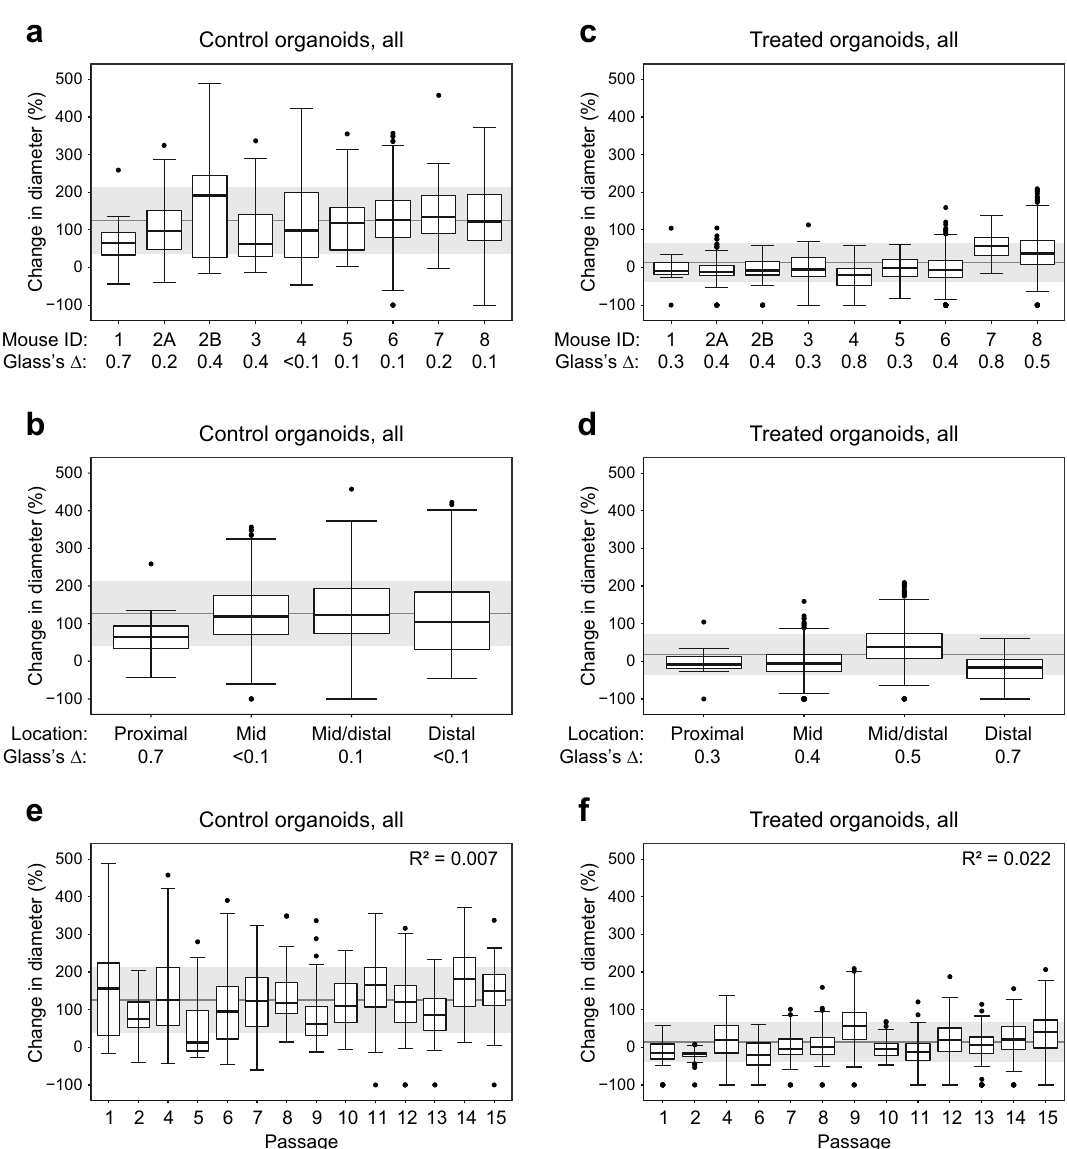
Figure 3. MDCOs derived from different mice of the same genotype or from different regions of the colon and passage number do not vary significantly in growth or drug response. Box and whisker plots displaying control organoids from ( a ) different mice of the same genotype and ( b ) tumors isolated from different regions of the colon. Box and whisker plots displaying treated organoids ( c ) derived from different mice of the same genotype and ( d ) tumors isolated from different regions of the colon. Each number represents a different mouse (1: n = 25 and n = 9, 2a: n = 125 and n = 234, 2b: n = 21 and n = 43, 3: n = 61 and n = 49, 4: n = 76 and n = 85, 5: n = 30 and n = 31, 6: n = 269 and n = 539, 7: n = 38 and n = 46, 8: n = 356 and n = 755, growth and response, respectively). Note that the MDCO line derived from mouse 1 was isolated from a proximal colon tumor and mouse 2 had two MDCO lines derived from two different colon tumors (distal: n = 106 and n = 116, mid/distal: n = 394 and n = 801, mid: n = 330 and n = 588, prox: n = 25 and n = 9, growth and response, respectively). Closest to the small intestine is the proximal colon moving more distally to the mid colon and finally the distal colon. Note the proximal colon has a different gross histology than the mid or distal colon. Box and whisker plots displaying the percent change in diameter for ( e ) growth and ( f ) drug response of MDCOs from passages 1–15 (P1: n = 26 and n = 69, P2: n = 23 and n = 63, P3: n = 0, P4: n = 87 and n = 91, P5: n = 10 and n = 0, P6: n = 68 and n = 83, P7: n = 82 and n = 84, P8: n = 57 and n = 132, P9:, n = 101 and n = 268, P10: n = 44 and n = 56, P11: n = 98 and n = 156, P12: n = 90 and n = 115, P13: n = 96 and n = 223, P14: n = 104 and n = 201, P15: n = 82 and n = 150, growth and response, respectively). In all box and whisker plots the grey line indicates the population change in diameter mean while the grey shading indicates one standard deviation above and below the population mean. Effect size was calculated using Glass’s delta to compare each mouse or tumor to the appropriate population